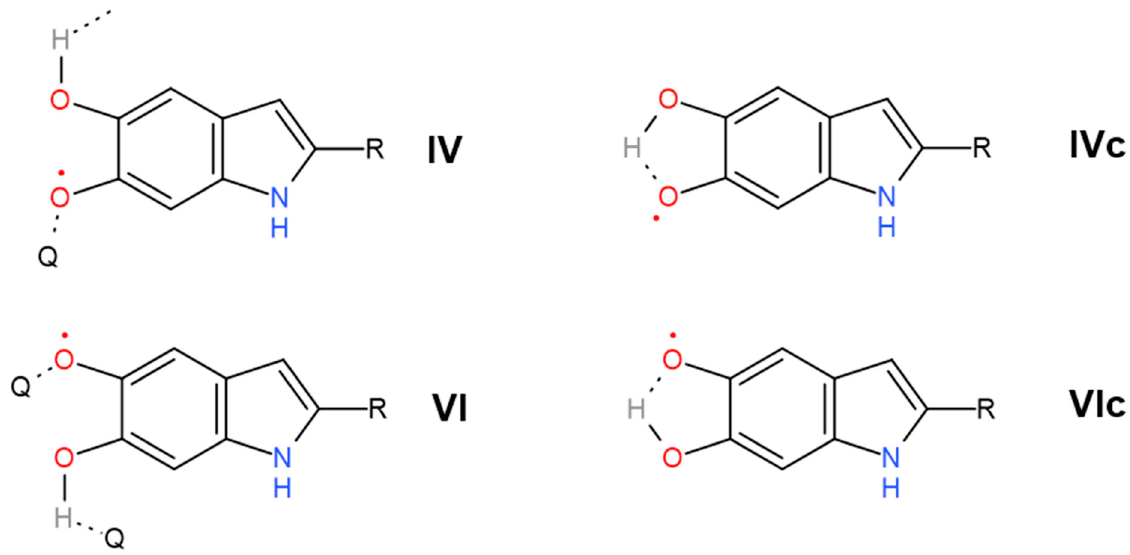
Figure 7. Introduction of the cycled forms of semiquinones, IVc and VIc . The non-cyclic forms IV and VI are taken from Figure 1 for comparison. The intramolecular hydrogen bond leads to the hindering of the corresponding O–H and C 𝌁 O vibrations. Within the framework of our interpretation, the cyclic form of semiquinone is mainly synthesized at the inter- face since, in this region, the concentration of other melanin units (Q) with which hydrogen bonds’ formation may happen is reduced. Following [83], the activation barrier of the transformation between IVc and VIc (or reverse chemical reaction) can be crossed at room temperature. Therefore, one of these forms can be redundant.